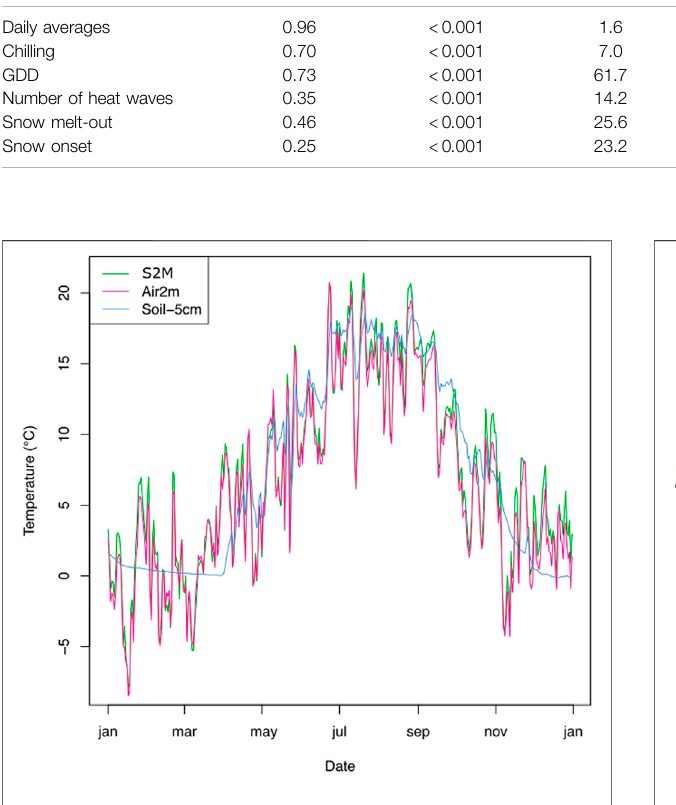
FIGURE 2 | Temperatures measured from two sensors ( − 5 cm below soil surface and 2 m above the soil) of the station in Montroc and respective S2M air temperatures, during the year 2016.